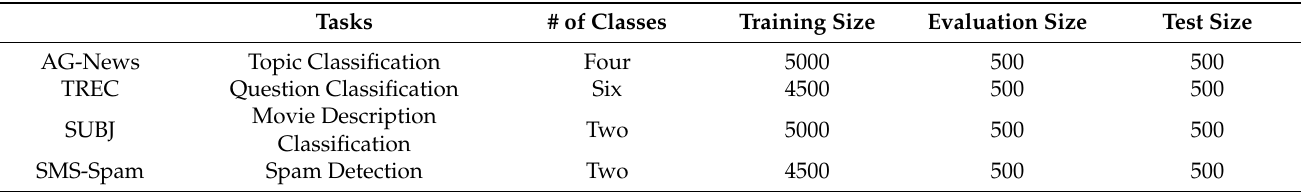
Table 1. Datasets